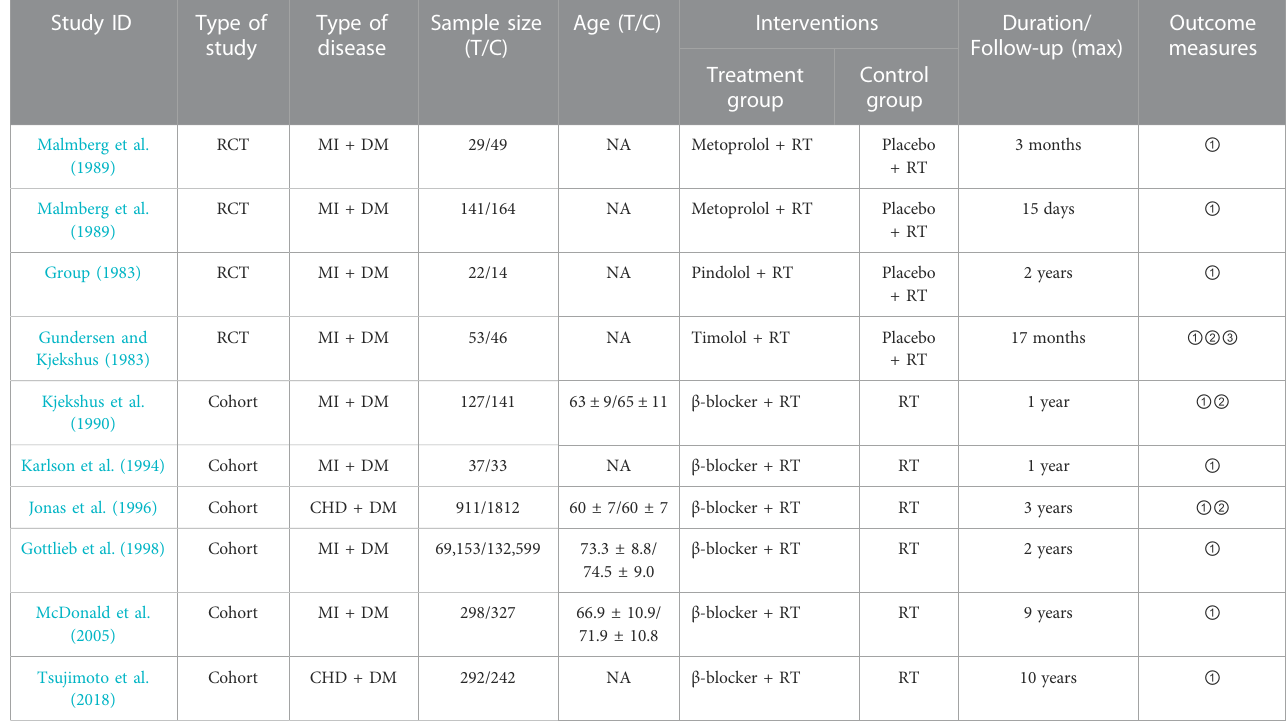
treatment group.